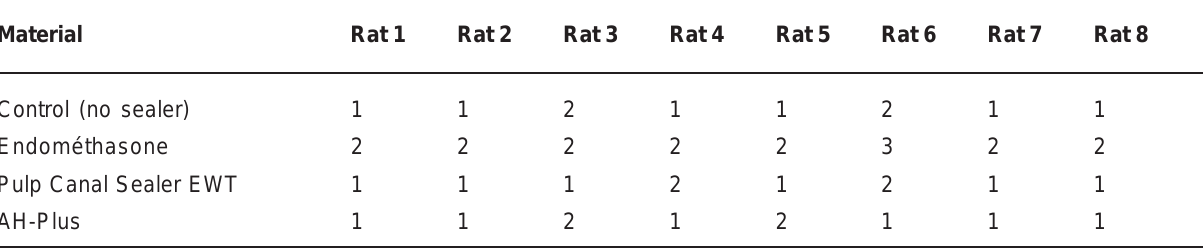
TABLE 3- Distribution of the scores attributed to the materials (Day 7)